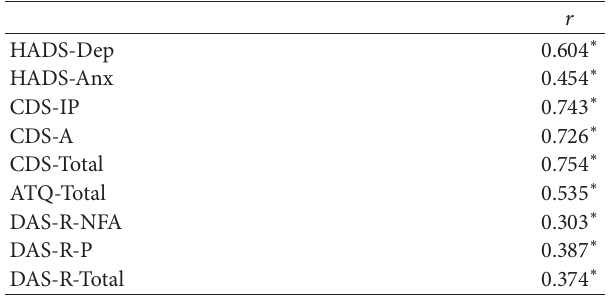
Table 3: Bivariate correlations between the CD-Quest and the other